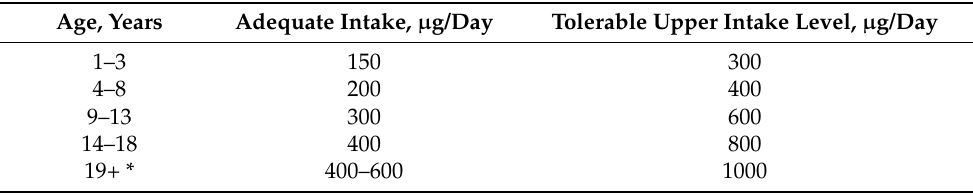
Table 2. Recommended levels of folic acid intake per day depending on